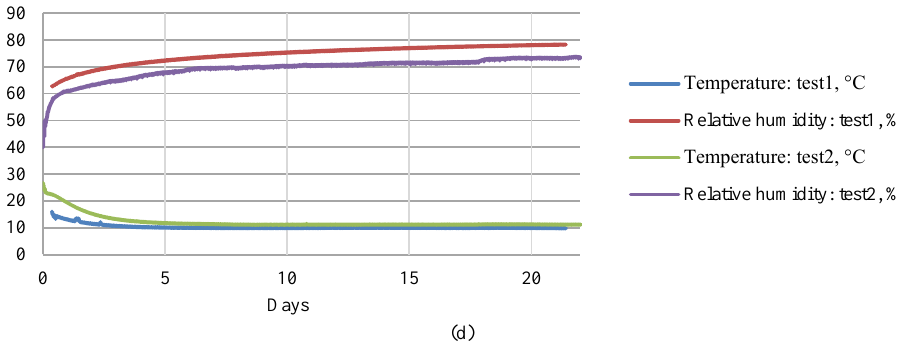
Fig. 5. Measured temperature and relative humidity between masonry and insulation layer: a) wood fiber, b) mineral wool, c) EPS, d) granulated aerogel.